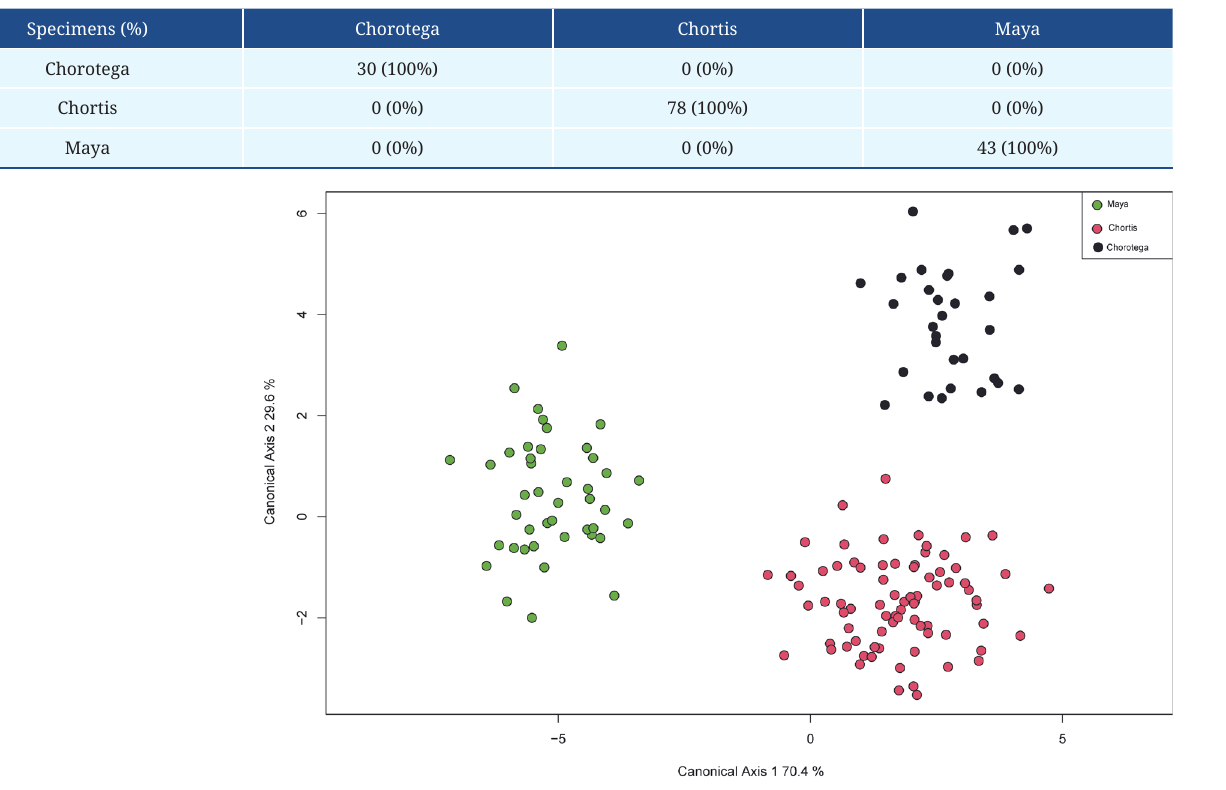
FIGURE 4 | Canonical variate analysis and shape changes along both axes. Shape change has been magnified by two for increased